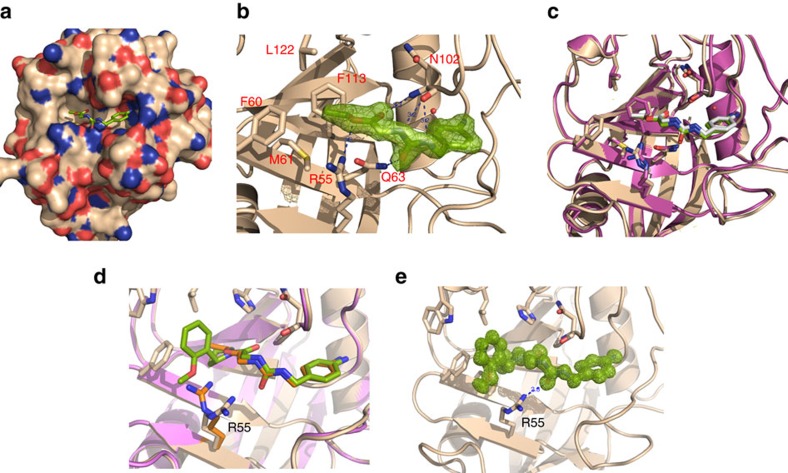
Co-crystal structure of compounds 22 and 24 with CypA and CypD.(a) Surface representation of CypD in complex with compound 22, showing occupation of both the catalytic site (left) and the gatekeeper pocket (right) of CypD. (b) Zoom into the catalytic site of CypD showing the urea moiety linker of compound 22 making four hydrogen bonds with Arg55, Gln63 and Asn102. The green mesh and surface represents the electron density map of compound 22 (2Fo–Fc omit map contoured at 1.0σ). (c) Superimposition of the CypD-compound 22 (pink for CypD, green sticks for compound 22) and the CypA-compound 22 (purple for CypA, white sticks for compound 22) co-crystals, showing identical binding modes. (d) Superimposition of the CypD-compound 24 cocrystal (pink for CypD, green sticks for compound 24) with the CypD-compound 22 co-crystal (purple for CypD, orange sticks for compound 22). The side chain of Arg55 is shown in stick format (pink for compound 24 and orange for compound 22). Compound 24 shares the same mode of CypD binding as compound 22 and its methoxy group pushes Arg55 to create a hydrogen bond with the urea moiety of the compound. (e) Cartoon representations of CypD in complex with compound 24, showing occupation of the gatekeeper pocket and the catalytic site of CypD. The side chain of Arg55 is represented in stick format to show the interaction with the urea moiety. The green mesh and surface represent the electron density maps (2Fo–Fc omit map contoured at 1.0σ).